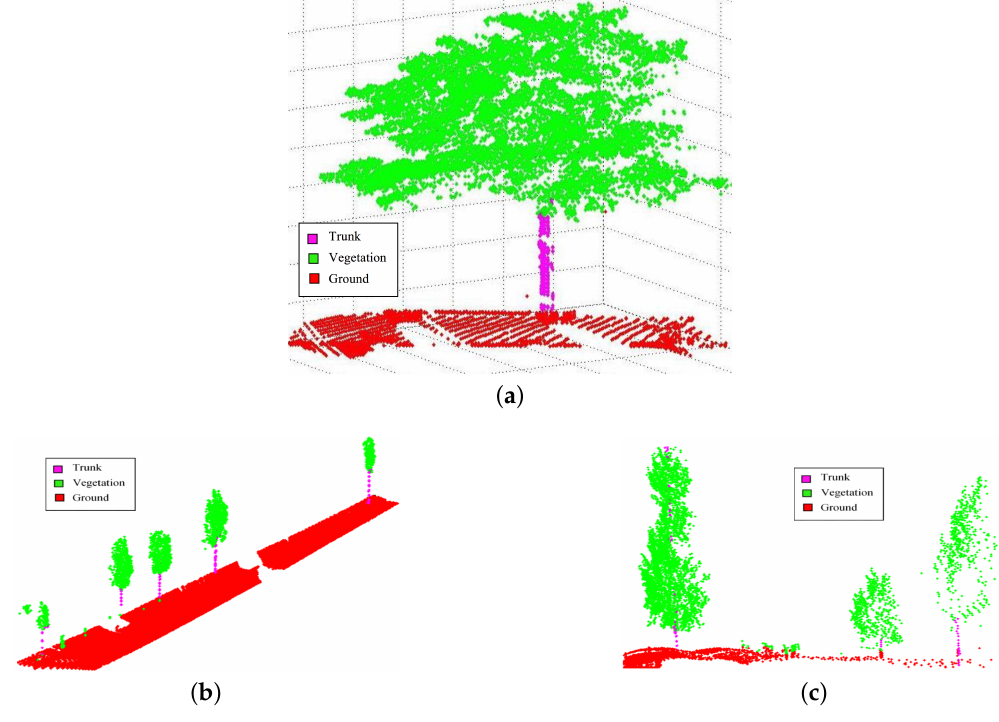
Figure 11. ( a – c ) present some segmentation and classification results for trees in the urban environment around the Kentucky area, USA using a vehicle borne mobile mapping scanning system